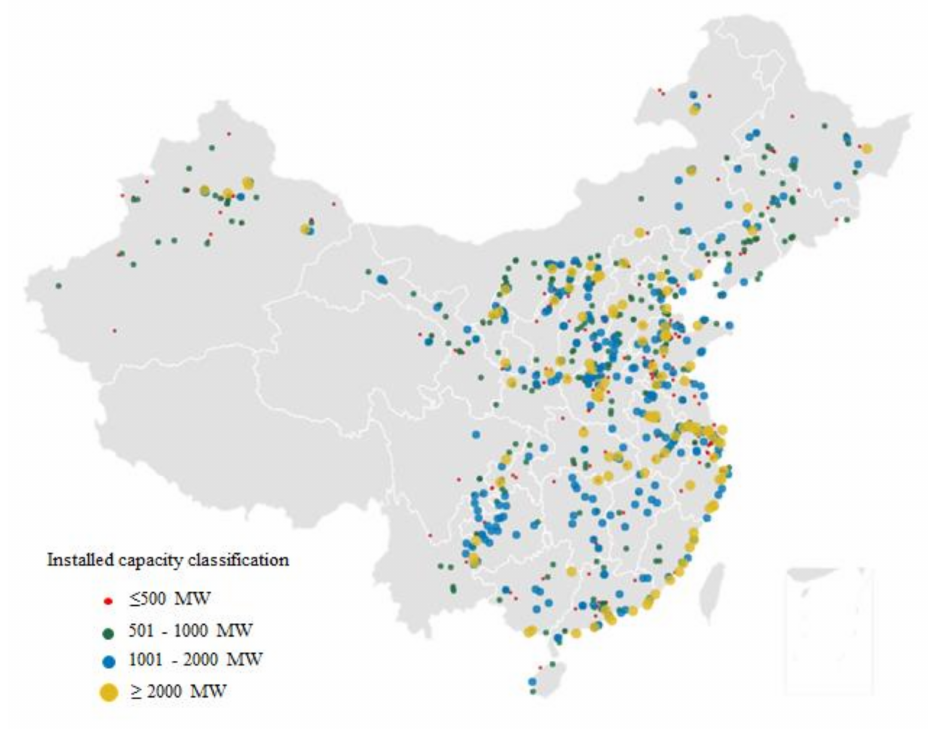
Figure 1. Location and size of existing coal plants in